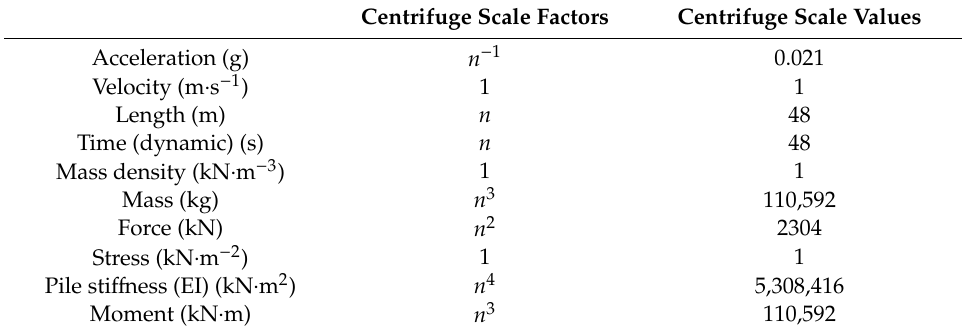
Table 2. Prototype and model properties (scale factor = 48).